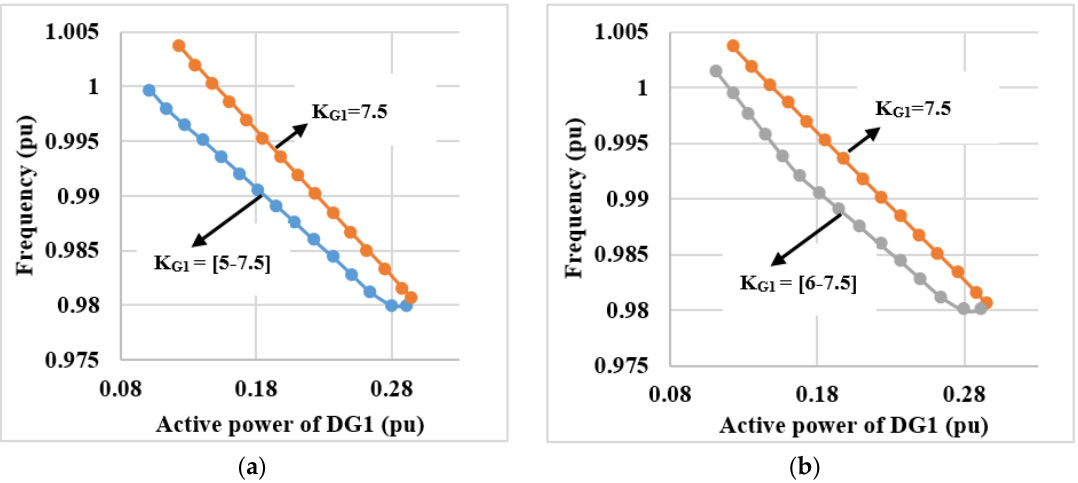
Figure 8 . P-f relation curves: ( a ) P-f relation of DG 1 with K G 1 selected optimally in the range [5 – 7.5]; ( b ) P-f relation of DG 1 with K G 1 selected optimally in the range [6 – 7.5]. The active power P G 1 of the generator DG 1 , the power losses P loss and the frequency f as function of K G 1 are listed in Table 3. Table 3. New operating points of DG 1 droop curve in the three scenarios.